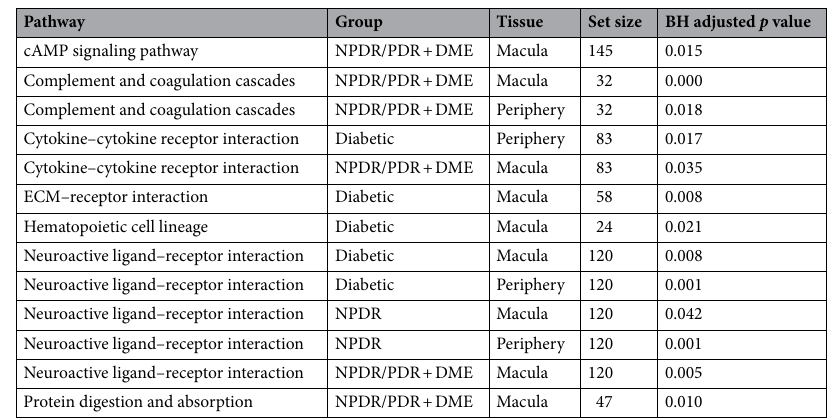
Table 2. Fold-change based pathway enrichment analysis: table shows results of the fold-change based pathway enrichment analysis conducted by GAGE. Group refers to the sample group for which fold-changes compared to healthy control samples were calculated. Set Size denotes the number of transcripts common in the 15,371 expressed transcripts in this study and the indicated KEGG